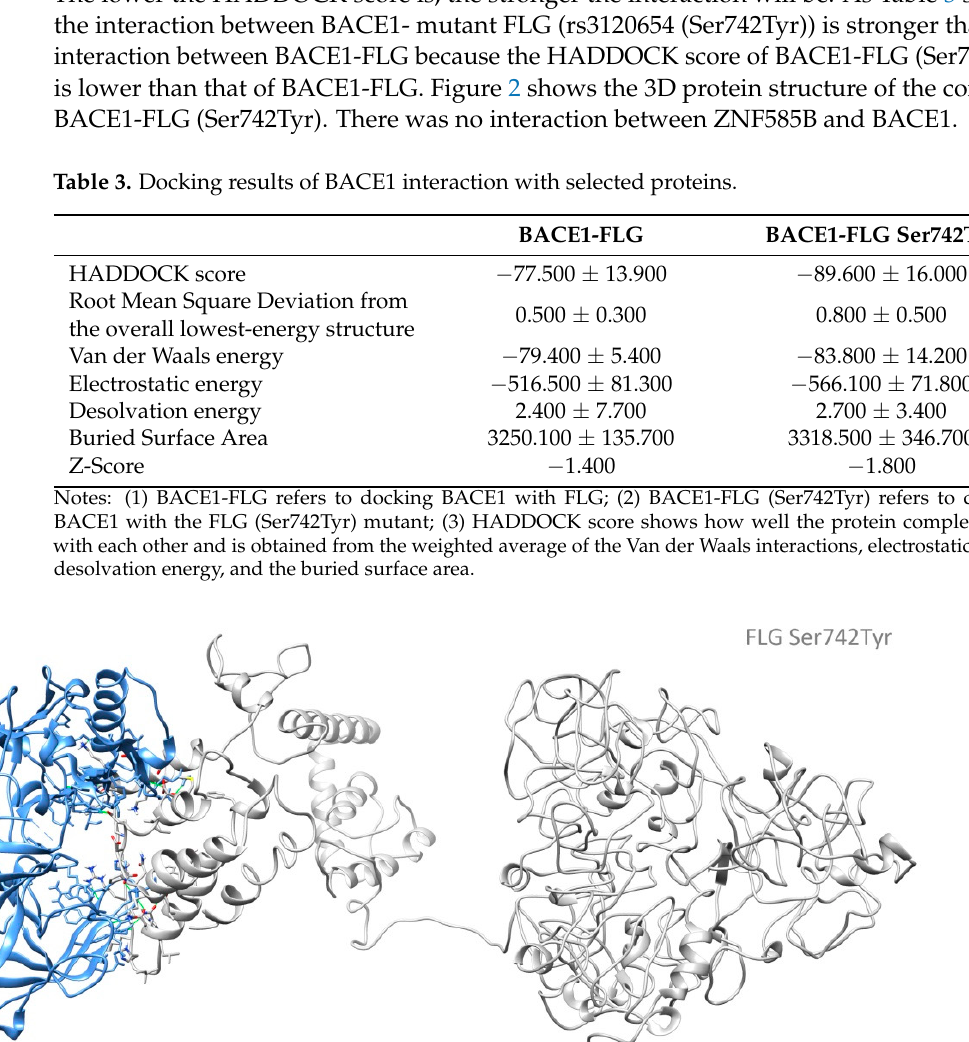
Table 3. Docking results of BACE1 interaction with selected proteins.